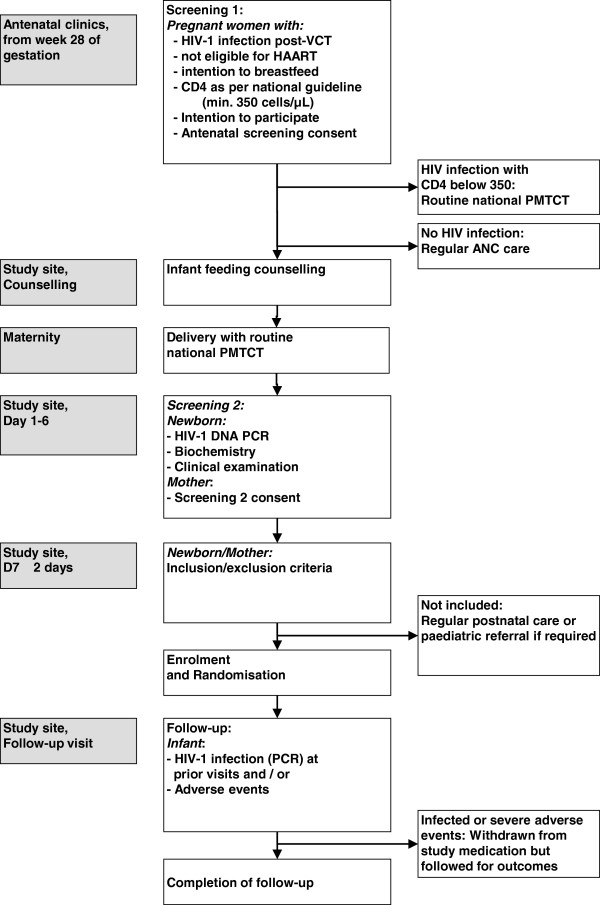
ANRS 12174 PROMISE-PEP trial screening, enrolment and follow-up visits contents.